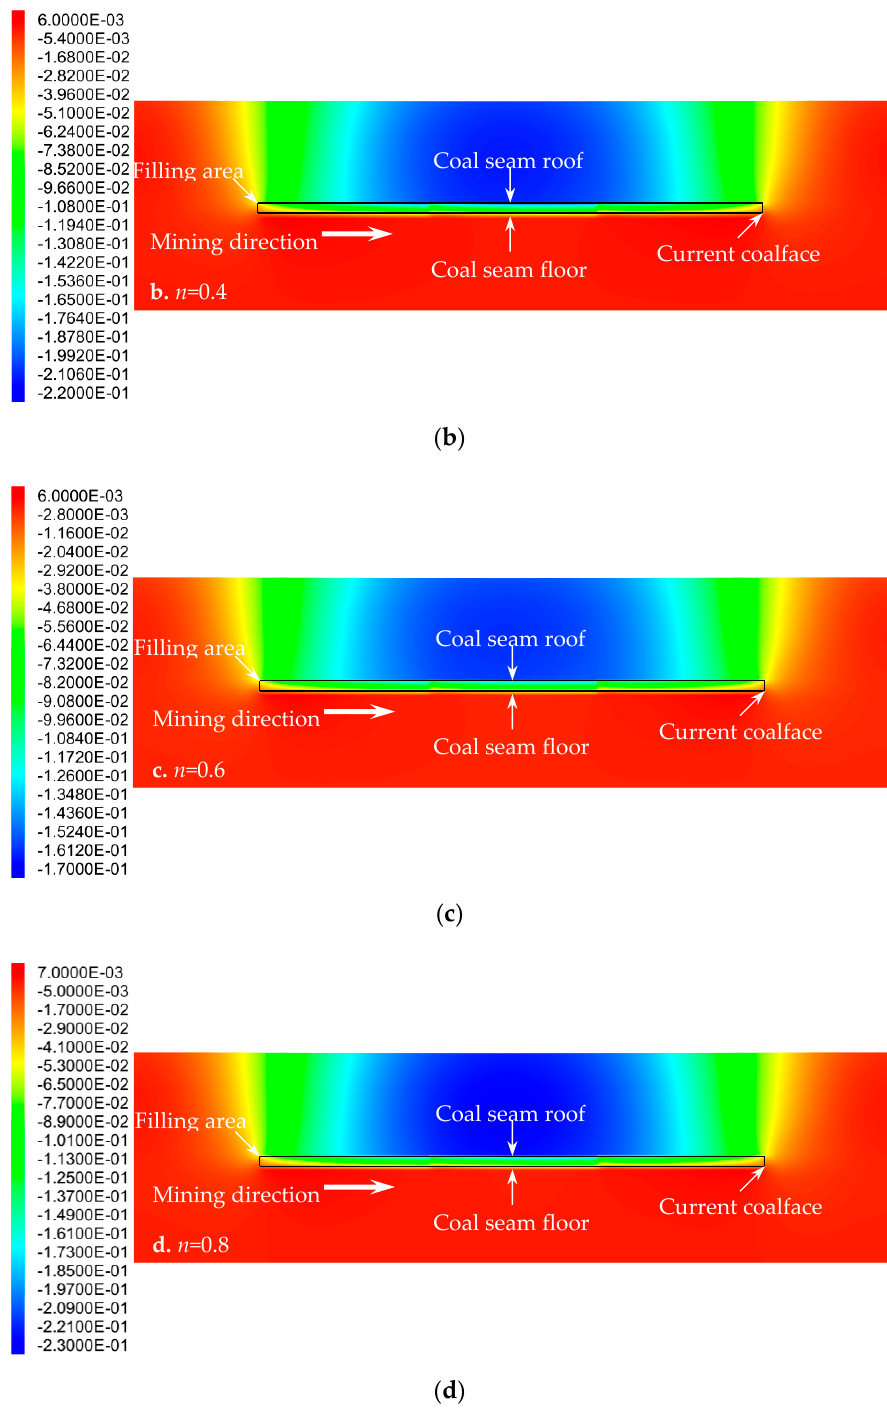
Figure 11. The Z-direction displacement field of the strata (Y–Z profile at X of 80 m) when the goaf was filled with cemented rockfill with different granule gradations at a mining distance of 120 m. n = 0.2 ( a ); n = 0.4 ( b ); n = 0.6 ( c ); and, n = 0.8 ( d ).